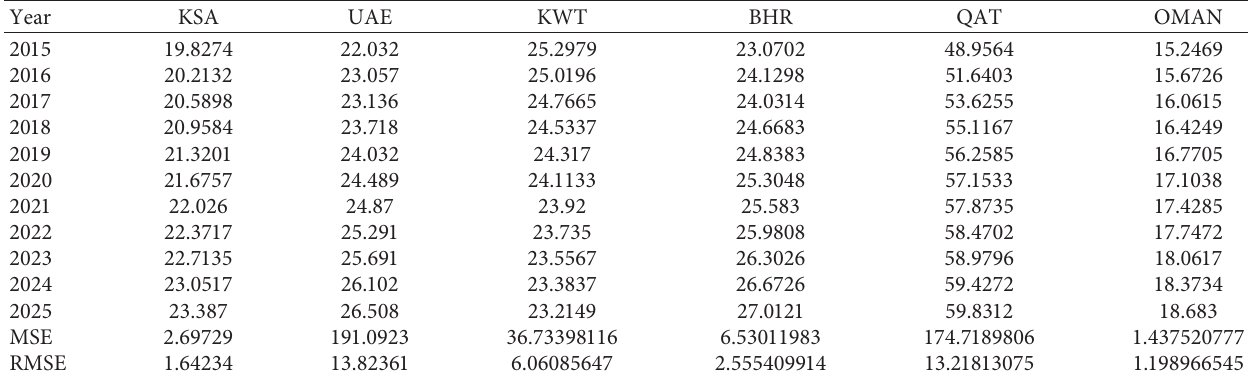
Table 2: Predicted value of CO 2 emissions (metric tons per capita) using the ARIMA (1,1,2) model and accuracy